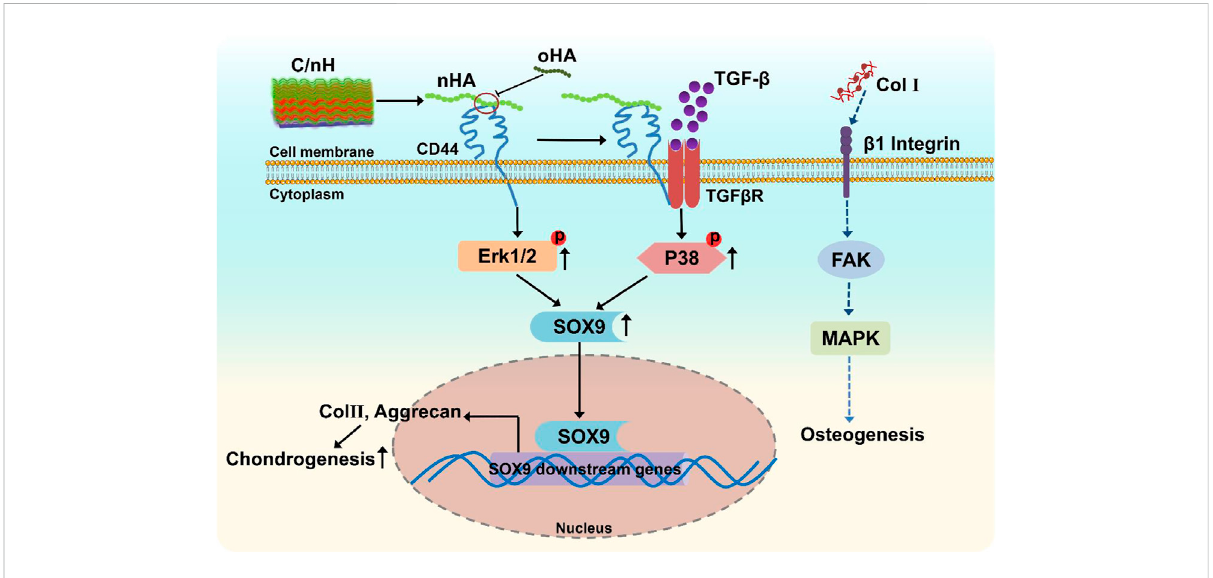
FIGURE 7 Scheme of the proposed mechanism of multilayer-promoted differentiation of MSC. nHA as component of Col I/nHA induce the clustering of CD44 which result in the activation of ERK/Sox9 and non-canonical TGF- β signaling pathways that are also related to induction of genes involved in chondrogenesis. Opposite to that oHA with lower molecular weight disrupts the clustering of CD44 which results in reduced signal transduction across these pathways resulting in lower chondrogenesis. Col I as further component of multilayers ligates and clusters β 1 integrin which activatesthefocaladhesionkinase(FAK)-mitogenactivatedproteinkinase(MAPK)signaling pathwaysthatinducesmitosisofcellsbutalsopromotes